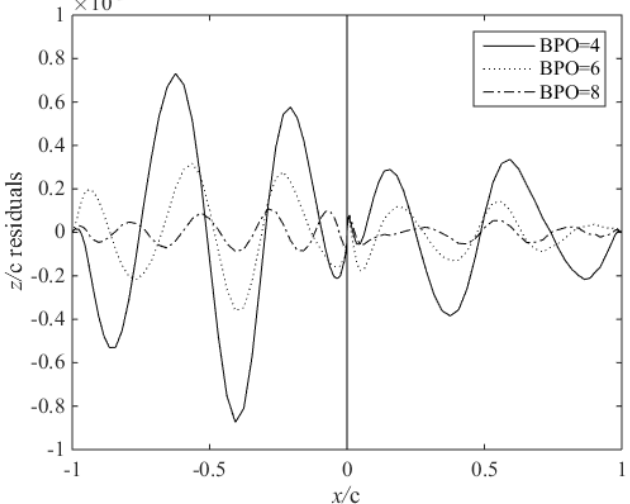
Figure 2. CST parameterization residuals of the RAE2822 airfoil.